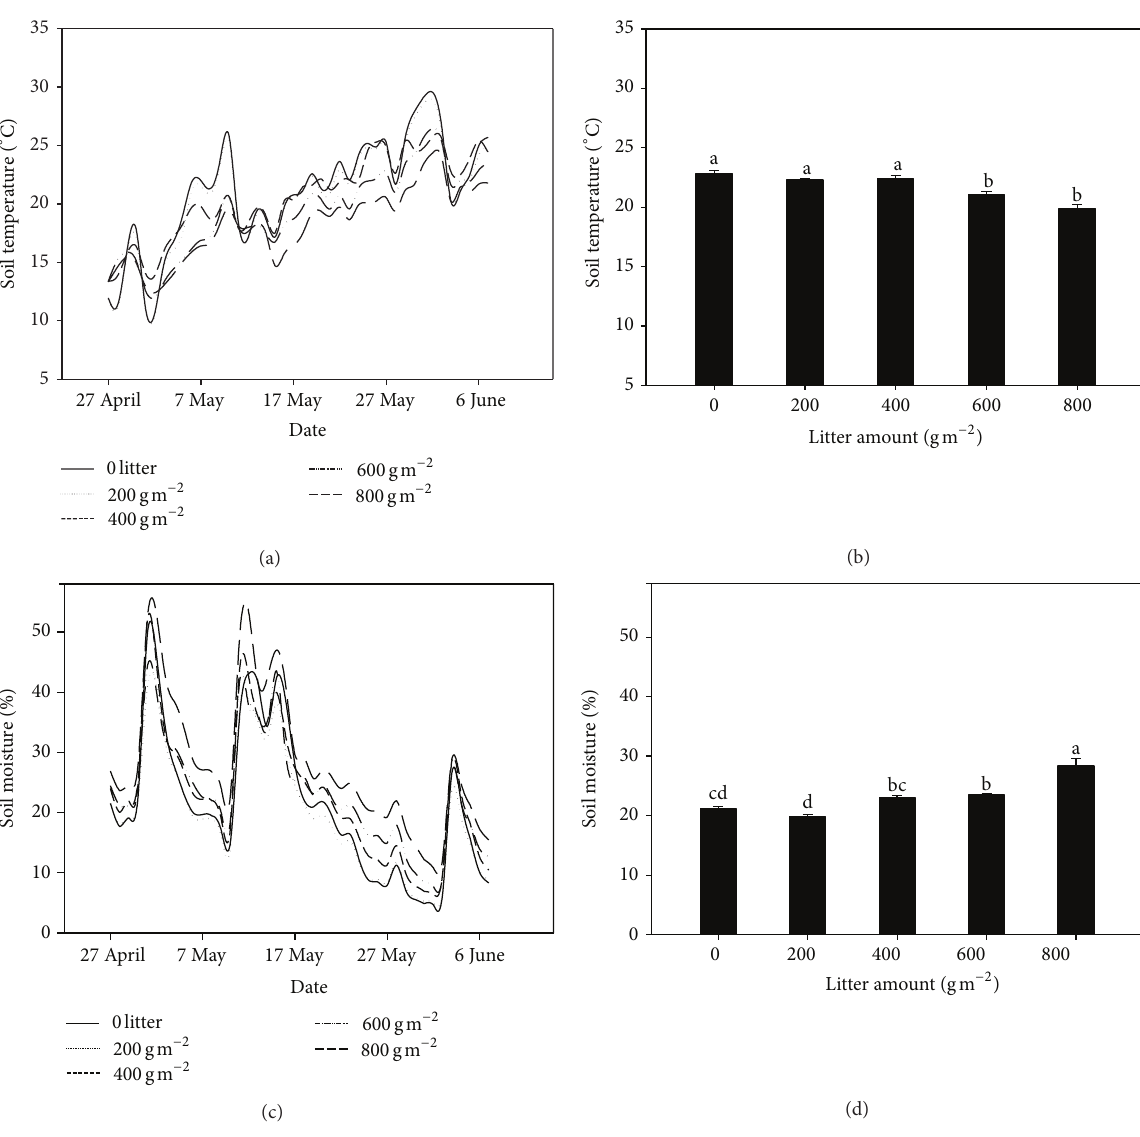
( 𝑃 < 0.001 ), which was significantly influenced by litter cover ( 𝑃 < 0.001 ; Figure 2(a)). Soil EC decreased with increase of litter cover over the experimental period (Figure